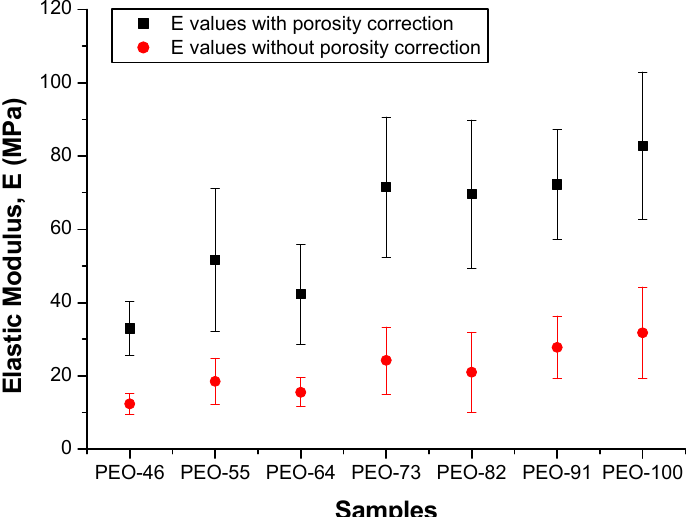
Figure 7. Young’s modulus of the blow spun PEO mats, with and without porosity correction. As expected, there is a clear difference between the moduli obtained for the as-prepared samples (red values) and after removing the contribution of the porosity (black values), being in this case around 60% higher, and close to the reported Young’s modulus for PEO [42–55]. On the other hand, Young’s moduli increase when the proportion of chloro- form in the solvent is used for SBS regardless of the porosity. Other mechanical parameters were also extracted from the stress-strain plots, maximum stress, σ max (Figure S9), stress at failure, σ f (Figure S10), and yield strength, σ y (Figure S11). All of them show similar tendencies, pointing out that mechanical parameters referring to the material strength increase as the proportion of chloroform in the solvent used for SBS increases. These results indicate that variations of structure and/or morphology are affecting mechanical